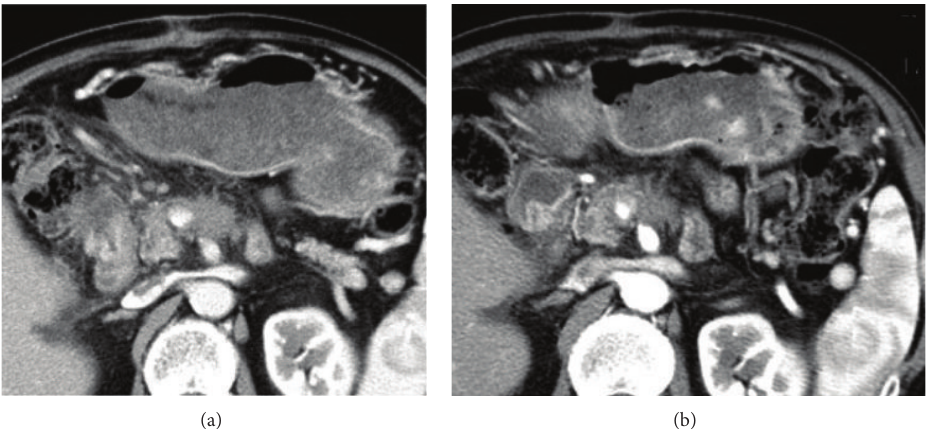
Figure 5: CT imaging shows no apparent change of pancreas (a) before and (b) after HIFU therapy (used with permission [18]).